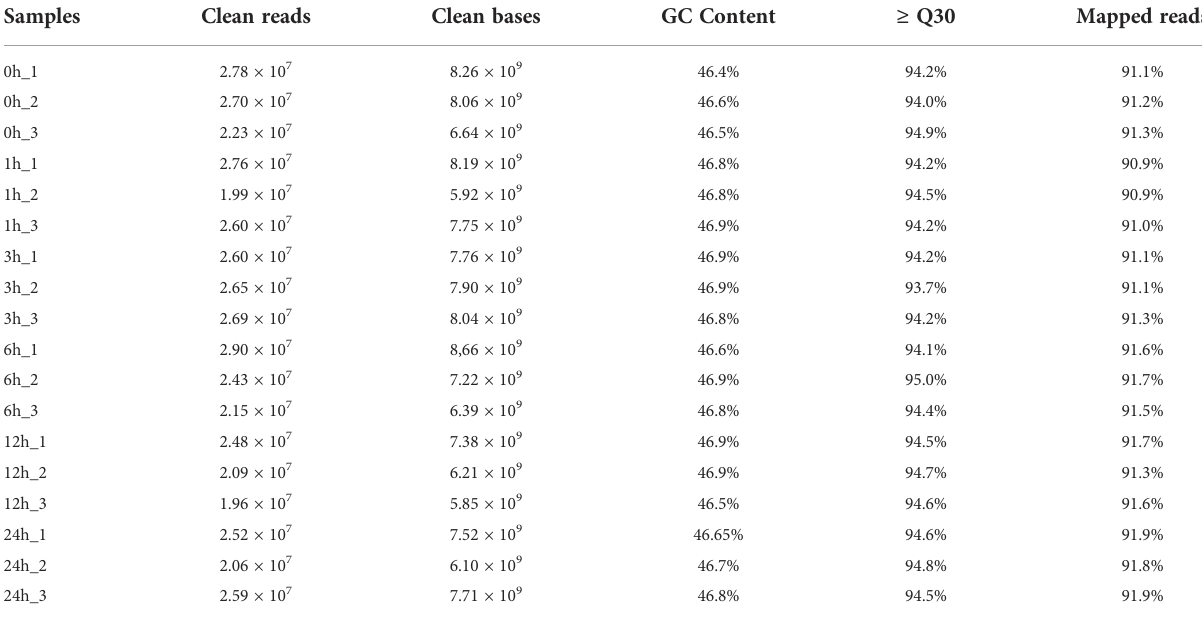
TABLE 1 Summary of sequencing data.